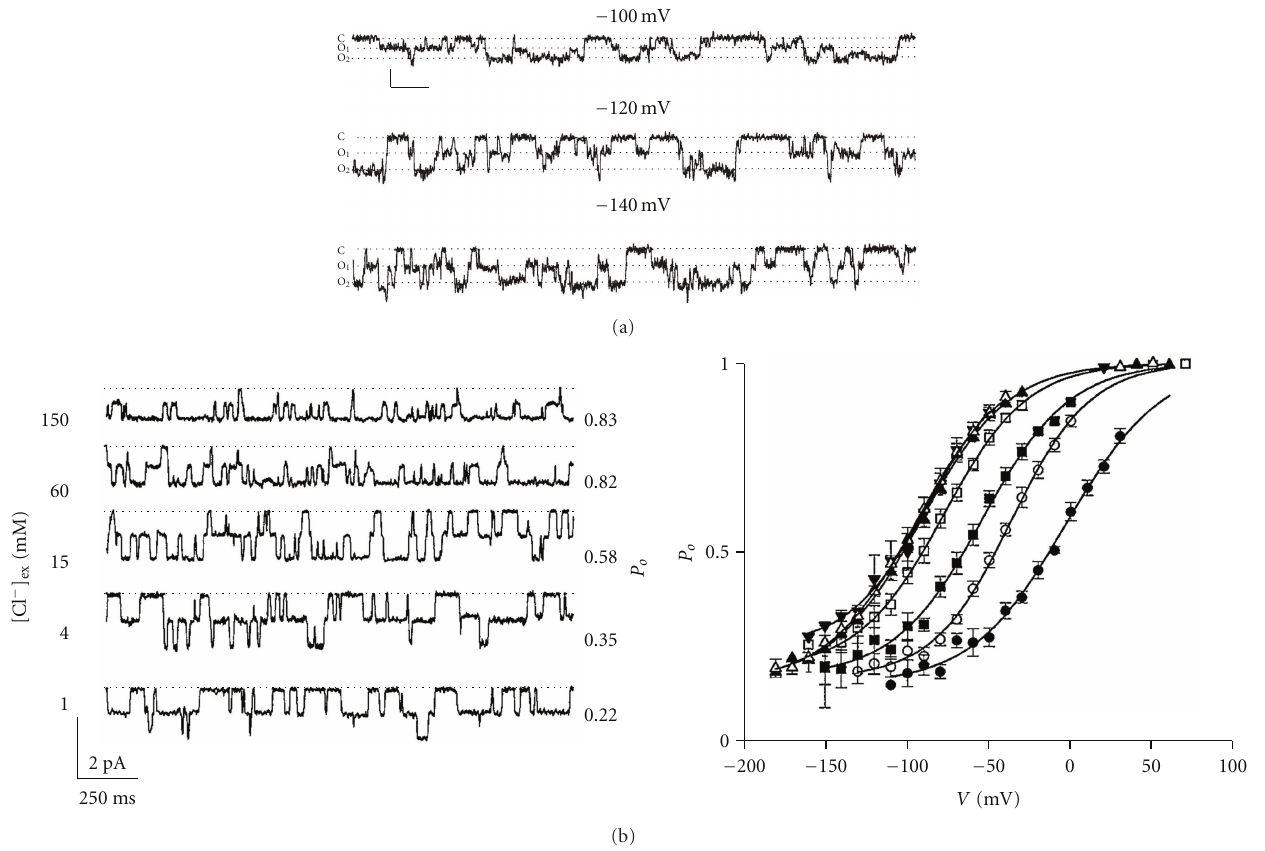
Figure 1: Molecular functions of CLC-channels. (a) Single-channel recordings of CLC-1 showing the “double-barreled” behavior. Dotted lines depict the three current levels: C: closed state, O1: one protopore open, and O2: both protopores open. Horizontal and vertical scale bars represent 200 ms and 0.2 pA, respectively. Notice that the three current levels are separated in equi-distance. Figure, taken from Saviane et al. [42] (© Rockefeller University Press, 1999). (b) E ff ects of extracellular Cl − on the fast-gate open probability of the Torpedo CLC-0 Cl − channel. Left panel shows single-channel recordings of CLC-0 at di ff erent extracellular Cl − concentrations indicated on the left. The calculated open probabilities of the fast gate in each Cl − concentration are shown on the right. Membrane potentials in all recordings are − 60mV. Right panel shows a summarized result for the Cl − e ff ect on the fast-gate P o - V curve. The extracellular Cl − concentrations are 300mM and those indicated in the left panel. As the extracellular Cl − concentration is reduced (from 300 mM to 1mM), the fast-gate P o - V curve is shifted to the more depolarized membrane potential. A similar Cl − e ff ect on the fast-gate P o - V curve has been observed in CLC-1. Figures, taken from Chen and Miller [45] (© Rockefeller University Press,